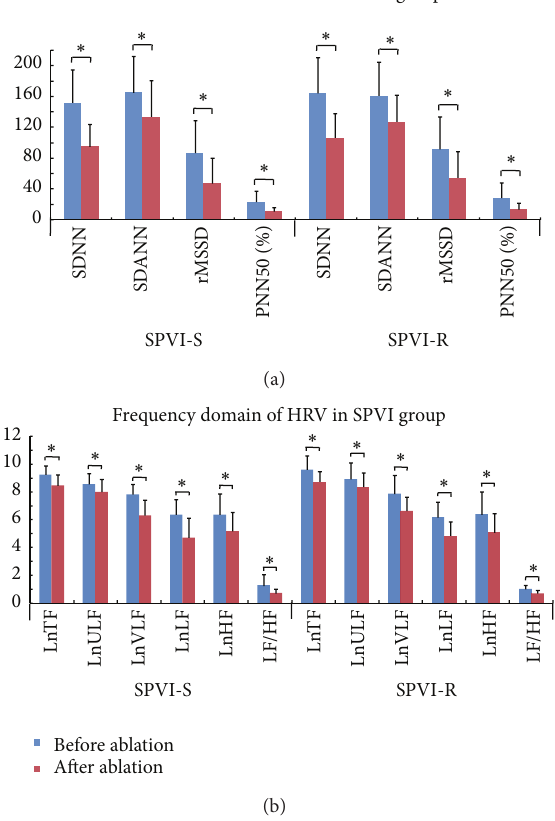
Figure 1: Comparison of HRV parameters before and after SPVI. (a) Time-domain parameters of HRV significantly decreased after SPVI in both the success and recurrence subgroups ( 𝑃 < 0.05 versus before ablation). (b) Frequency-domain characteristics of HRV sig- nificantly decreased in both the success and recurrence subgroups ( 𝑃 < 0.05 versus pre-ablation). HRV: heart rate variability; SPVI-S: success subgroup for segmental pulmonary vein isolation; SPVI-R: recurrencesubgroupforsegmentalpulmonaryveinisolation;CPVI- S: success subgroup for circumferential pulmonary vein isolation; CPVI-R: recurrence subgroup for circumferential pulmonary vein isolation; SDNN: standard deviation of all NN intervals (ms); SDANN,standarddeviationoftheaveragesoftheNNintervalsinall 5-min segments (ms); rMSSD: root mean square root of the differ- ences between adjacent NN intervals (ms); PNN50, percentage of adjacent NN interval differences > 50ms; ULF: ultralow-frequency power; VLF: very-low-frequency power; LF, low-frequency power; HF, high-frequency power. Frequency domain parameters of HRV including TF, ULF, VLF, and LF and HF were logarithmically transformed to normalize the distribution (LnTF, LnULF, LnVLF, LnLF, and LnHF; units: ms 2 ). ∗ 𝑃 < 0.05 .